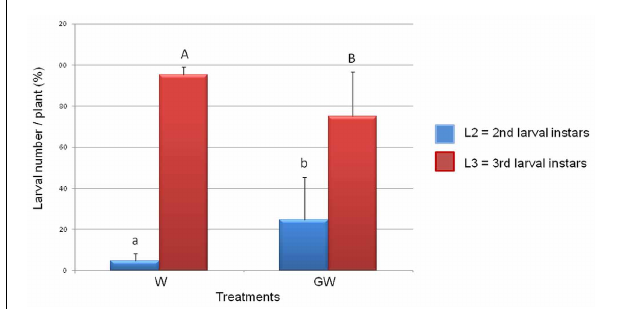
FIGURE 1 | Effect of Glomus intraradices on WCR larval development. The number of 3rd larval instars (L3) was significantly lower in the Glomus -treated plants (treatment GW) than in untreated control plants (treatment W). Four biological replicates per treatment were used. The error bars represent standard deviations. Lowercase letters above columns indicate significance differences between the number of L2 larval instars, while uppercase letters indicate significance differences between L3 larval numbers ( P = 2 e − 16